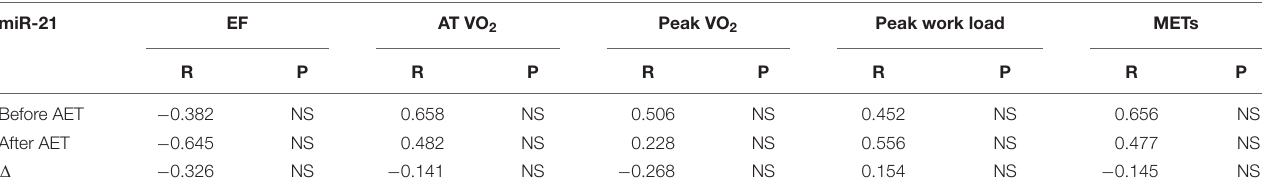
TABLE 5 | Correlation analysis between miRNA changes following AET and cardiopulmonary function indexes. miR-21 EF AT VO 2 Peak VO 2 Peak work